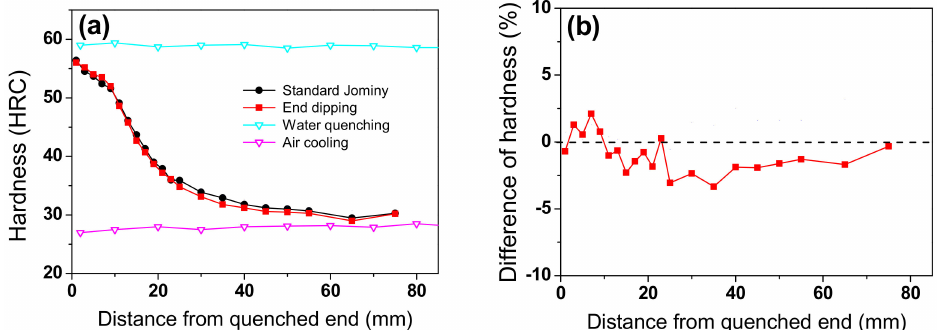
Figure 11. Comparison of ( a ) hardness profiles and ( b ) hardness difference of the Jominy specimen during the SH and ED cooling conditions.